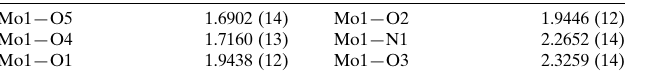
Selected bond lengths (A˚ ).